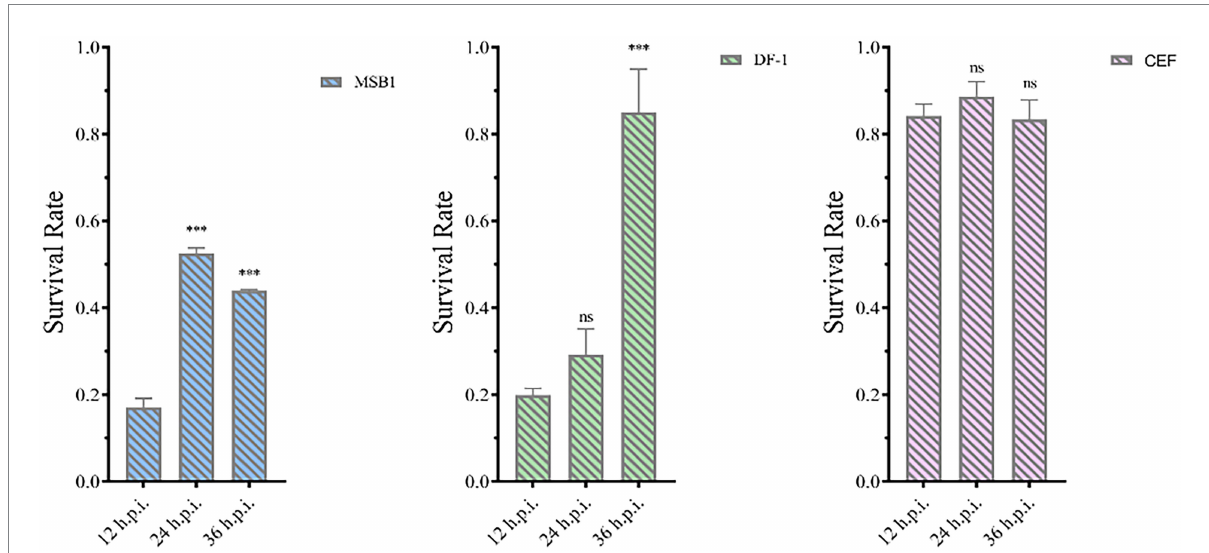
FIGURE 12 Activity of different types of cells. Activities of MSB1 (A) , DF-1 (B) , and CEF (C) cells at different time points. *** p < 0.001, ns is not significant.